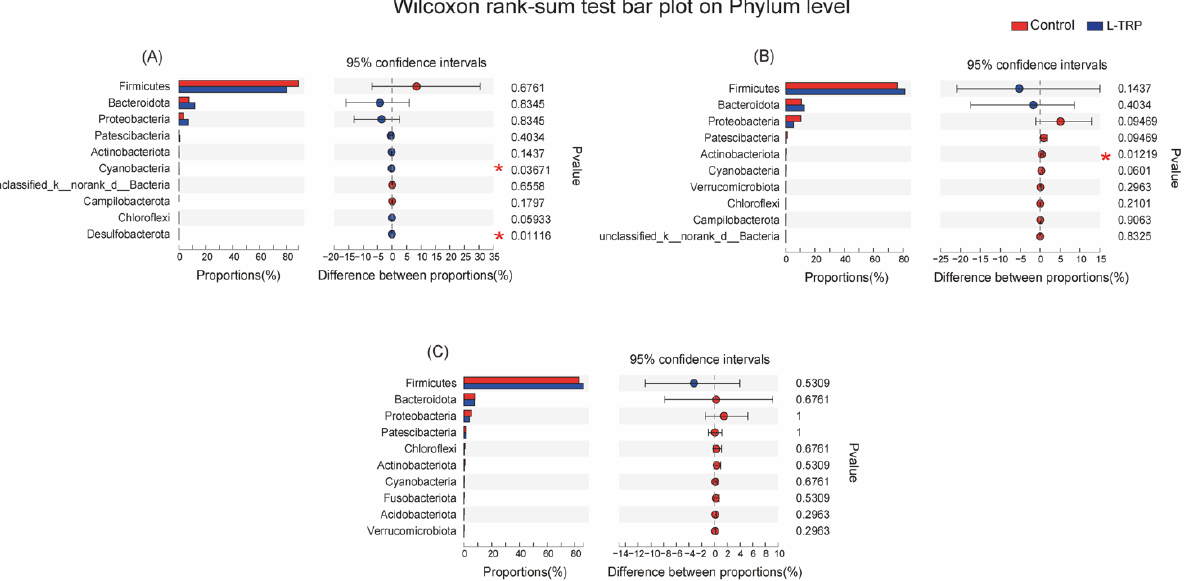
Figure 6. Structure and composition of the intestinal microbial composition of E. sinensis (phylum